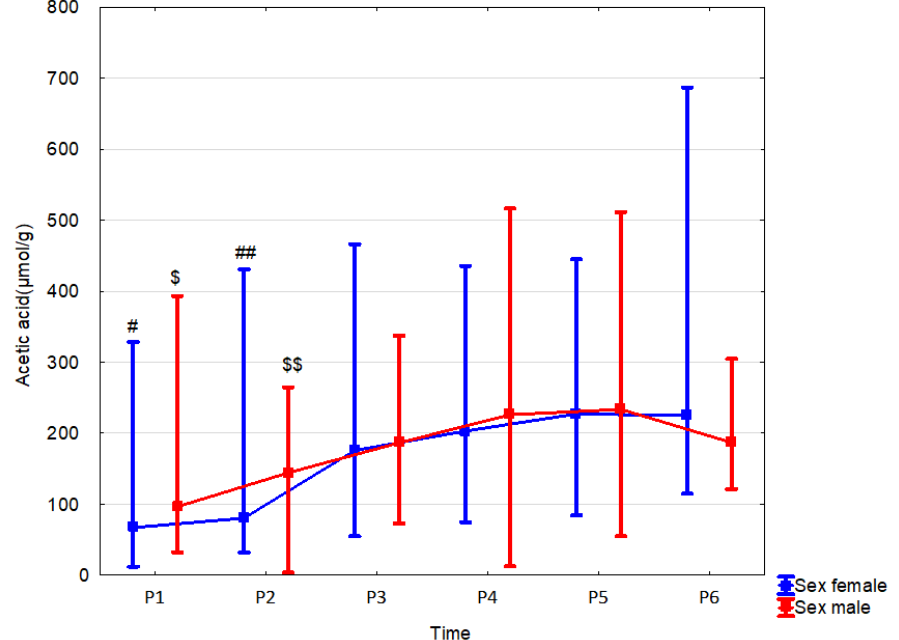
Figure 8. Acetic acid (median) in children over time according to the effect of sex: male (red line) or female (blue line). Legend: Error bars represent range. Wilcoxon paired tests regarding time, # (female), $ (male): #, $: p < 0.05 P1 vs. P4, P5 and P6; ##, $$: p < 0.05 P2 vs. P4,P5 and P6.